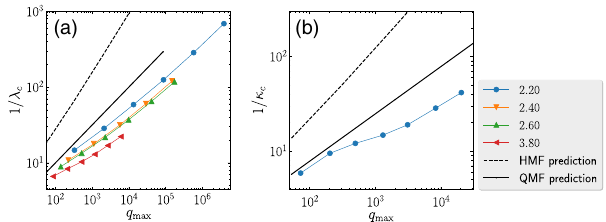
FIG. 3. (a) Largest eigenvalue Λ LPA networks with different degree exponent γ . (b) Inverse participation ratio Y 4 ð N Þ as a function of N in LPA networks with different degree exponent γ . Each point in both graphs corre- sponds to an average over 100 independent network realizations. Error bars are smaller than symbol sizes.